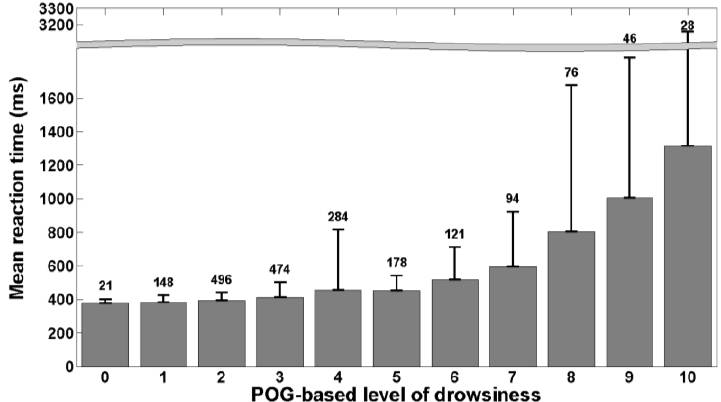
Figure 3. Mean reaction time as a function of POG-based level of drowsiness. Each bin represents the mean reaction time for each value of POG-based level of drowsiness. The error bars show the standard deviation around each mean value and the number above each bin indicates the number of 20-s windows falling into the bin.